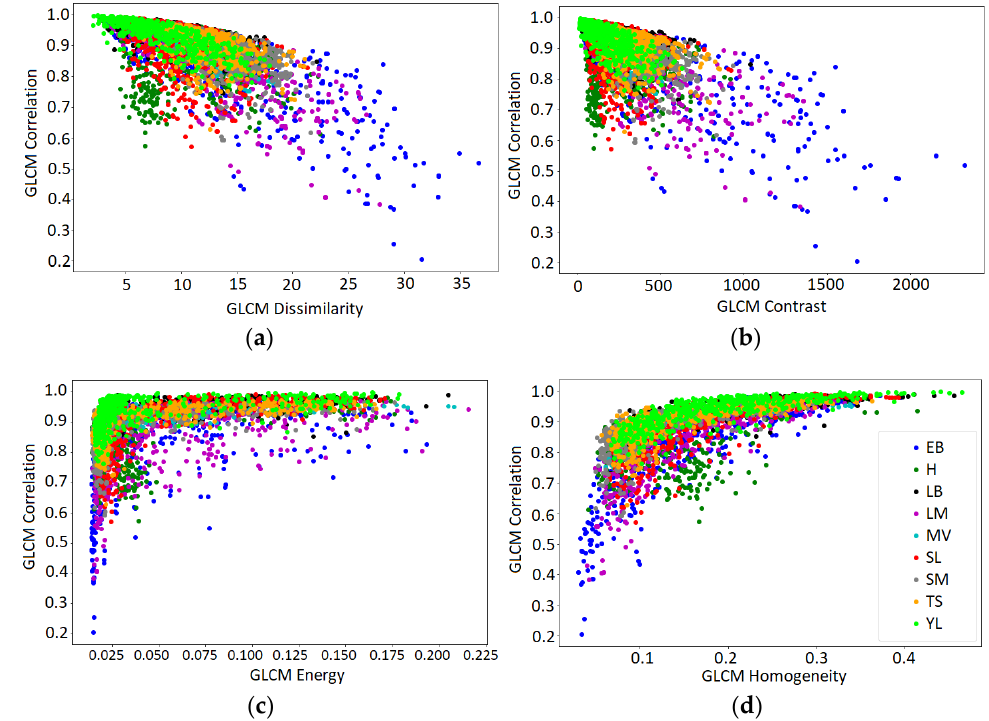
Figure 10. Graphical analysis of texture features extracted with GLMC. Correlation vs. ( a ) Dissimilarity, ( b ) Contrast, ( c ) Energy, ( d ) Homogeneity. EB: Early Blight, H: Healthy, LB: Late Blight, LM: Leaf Mold, MV: Mosaic Virus, SL: Septoria Leaf, SM: Spider Mite, TS: Target Spot, YL: Yellow Leaf.